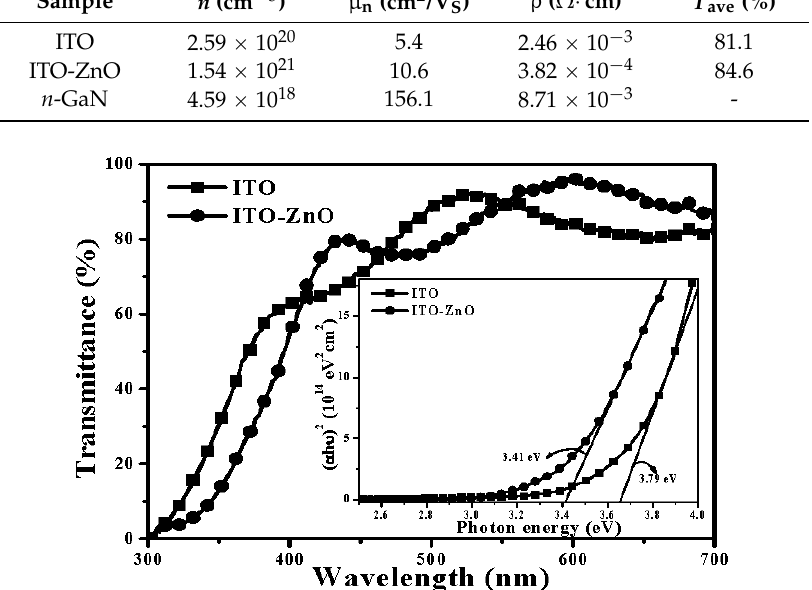
Figure 1. Optical transmittance spectra of the ITO and cosputtered ITO ‐ ZnO films (the corresponded optical energy band gaps determined from the ( α h ν ) 2 versus the photon energy (eV) also are provided in the inset figure).